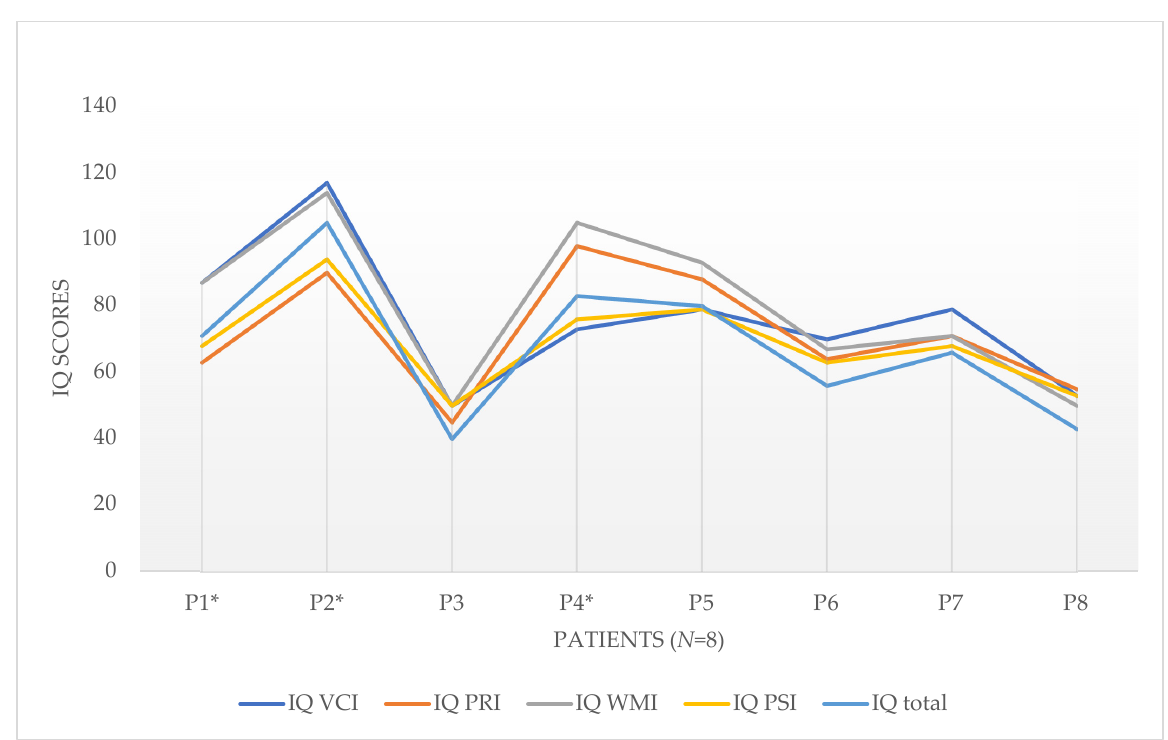
Figure 1. Profil IQ total and indices (WISC-IV), VCI = language comprehension, PRI = perceptual